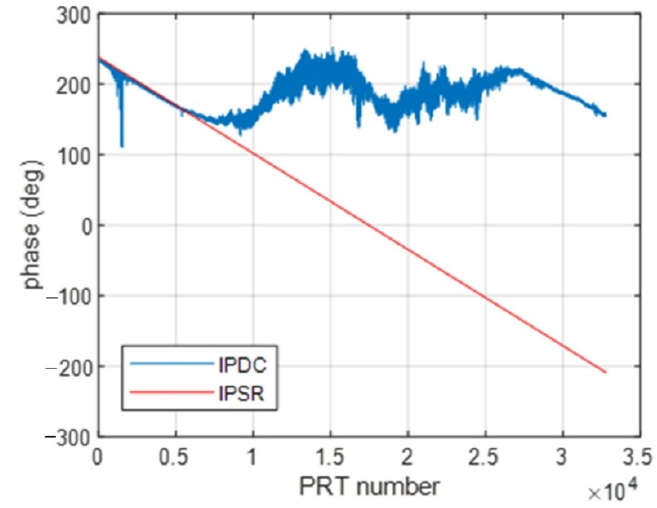
Figure 5. IPSRs and IPDCs along azimuth (0 dB JSR).